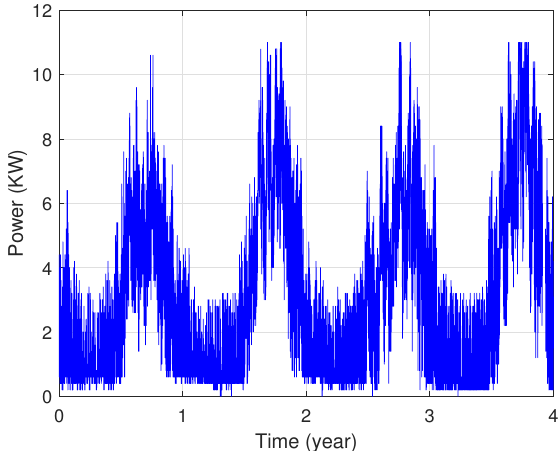
Figure 3. Power consumption of the first zone.